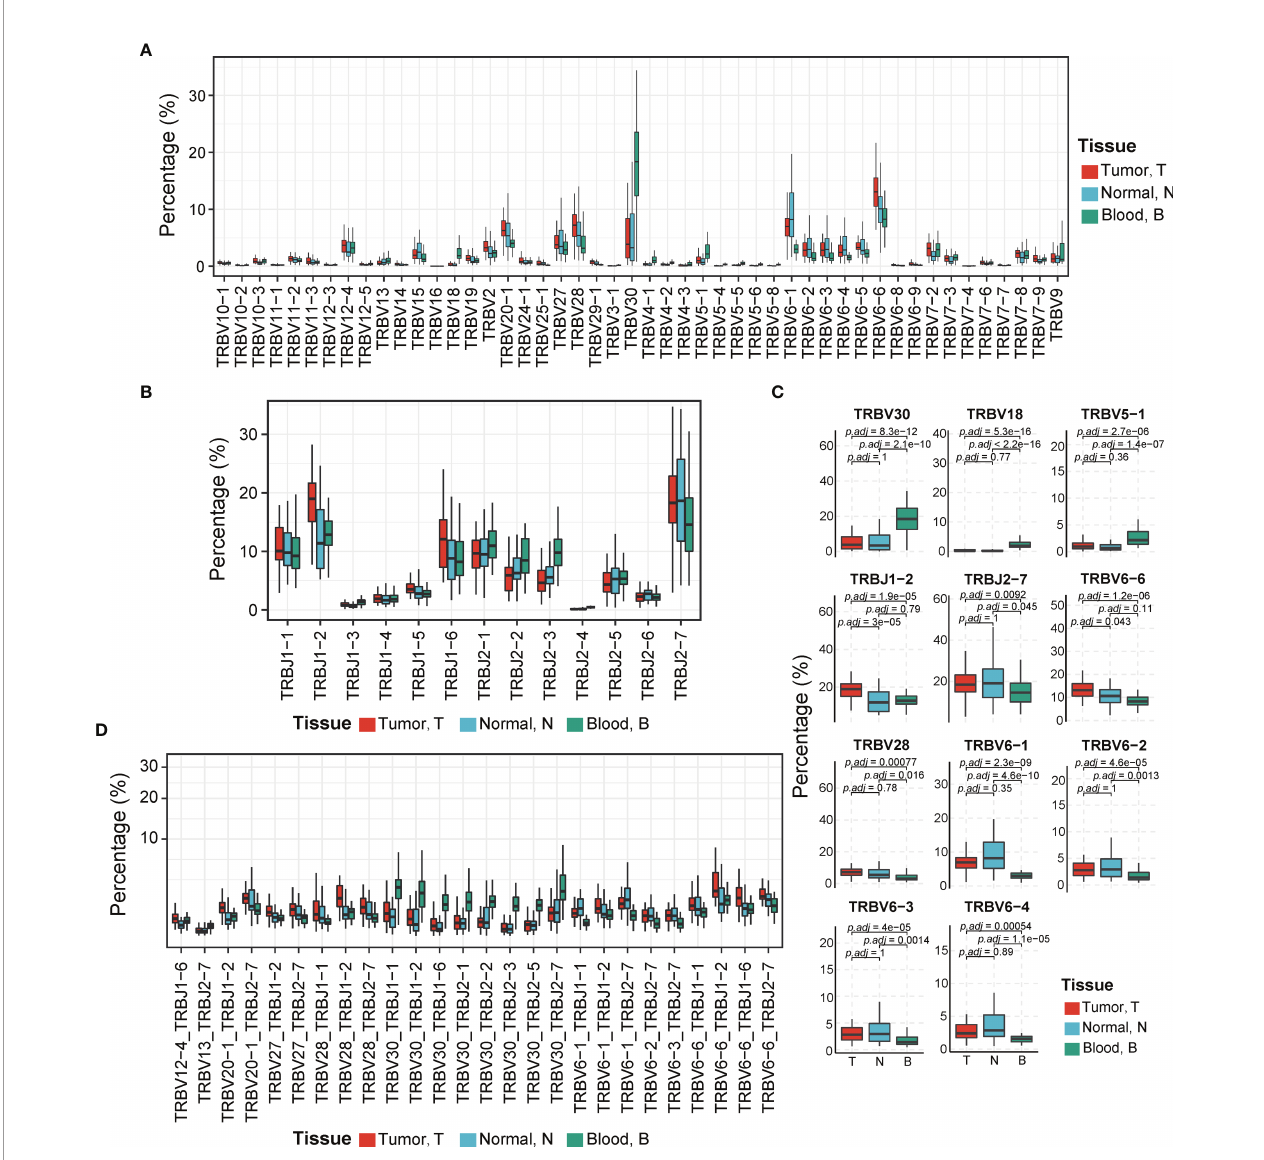
FIGURE 4 | Comparison of TCR V b , J b , and V b – J b paired gene usage in tumor, adjacent non-tumor tissues, and peripheral blood. (A) The usage abundances of 48 V b genes in three tissues. T, tumor; N, adjacent non-tumor tissues; B, peripheral blood. (B) The usage abundances of 16 J b genes in three tissues. (C) V b or J b genes have signi fi cant differential usage abundances in different tissues. p -Values are shown in the fi gure according to Kruskal – Wallis (for multiple groups ’ comparison) and Wilcoxon test (for two groups ’ comparison). p -Value adjusted by Bonferroni correction. (D) The usage abundances of 26 TCR V b – J b paired genes that have high abundance in three tissues (mean abundance >1%, p -Values <0.01, Kruskal – Wallis test). TCR, T-cell